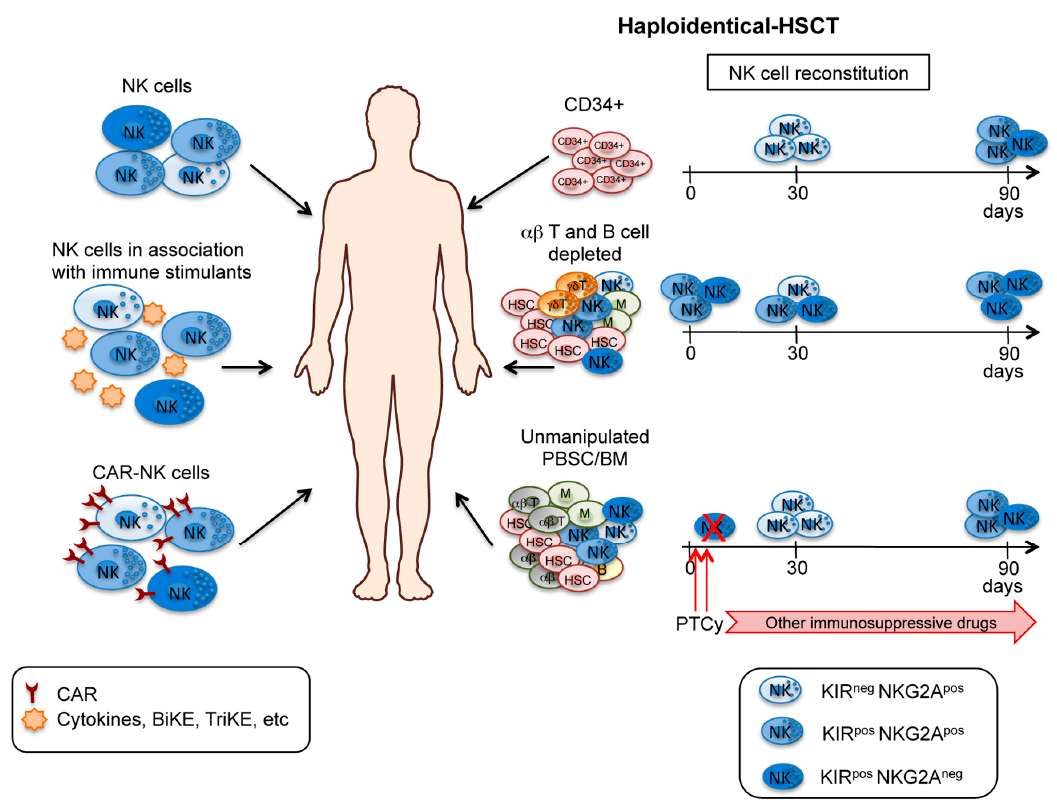
Figure 4. Different therapeutic approaches based on the use of natural killer (NK) cells. Adoptive transfer: infusion of unmodified allogeneic NK cells (directly or in combination with different types of immune stimulants) or chimeric antigen receptor (CAR)-modified allogeneic NK cells. Different strategies of haploidentical-HSCT: graft inoculum of “megadoses” of highly purified CD34 + cells; infusion of a αβ T- and CD19 B cell-depleted graft enriched for hematopoietic stem cells (HSC) and also containing other cell types, including mature (possibly alloreactive) NK cells and γδ T lymphocytes; infusion of unmanipulated peripheral blood stem cells (PBSC)/bone marrow (BM) and early (+3 +5 day) post-transplant high-dose cyclophosphamide (PTCy) administration that eliminates donor-derived proliferating cells, including all mature NK cells. Graft versus host disease (GvHD) prophylaxis is given only in the third type of transplant. NK cell reconstitution in the three haploidentical-hematopoietic stem cell transplantation (haplo-HSCT) platforms is depicted, differentiating different stages of maturation. Only in αβ T and CD19 B cell-depleted graft are mature NK cells infused and persist in the recipient. BiKE, bispecific killer engagers; TriKE, trispecific killer engagers.